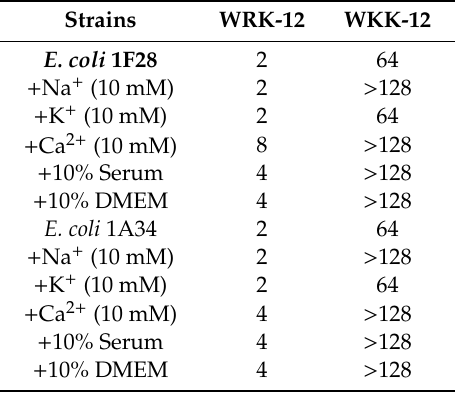
Table 4. Salt and serum stability of two amphiphilic peptides (MIC, µ g / mL).